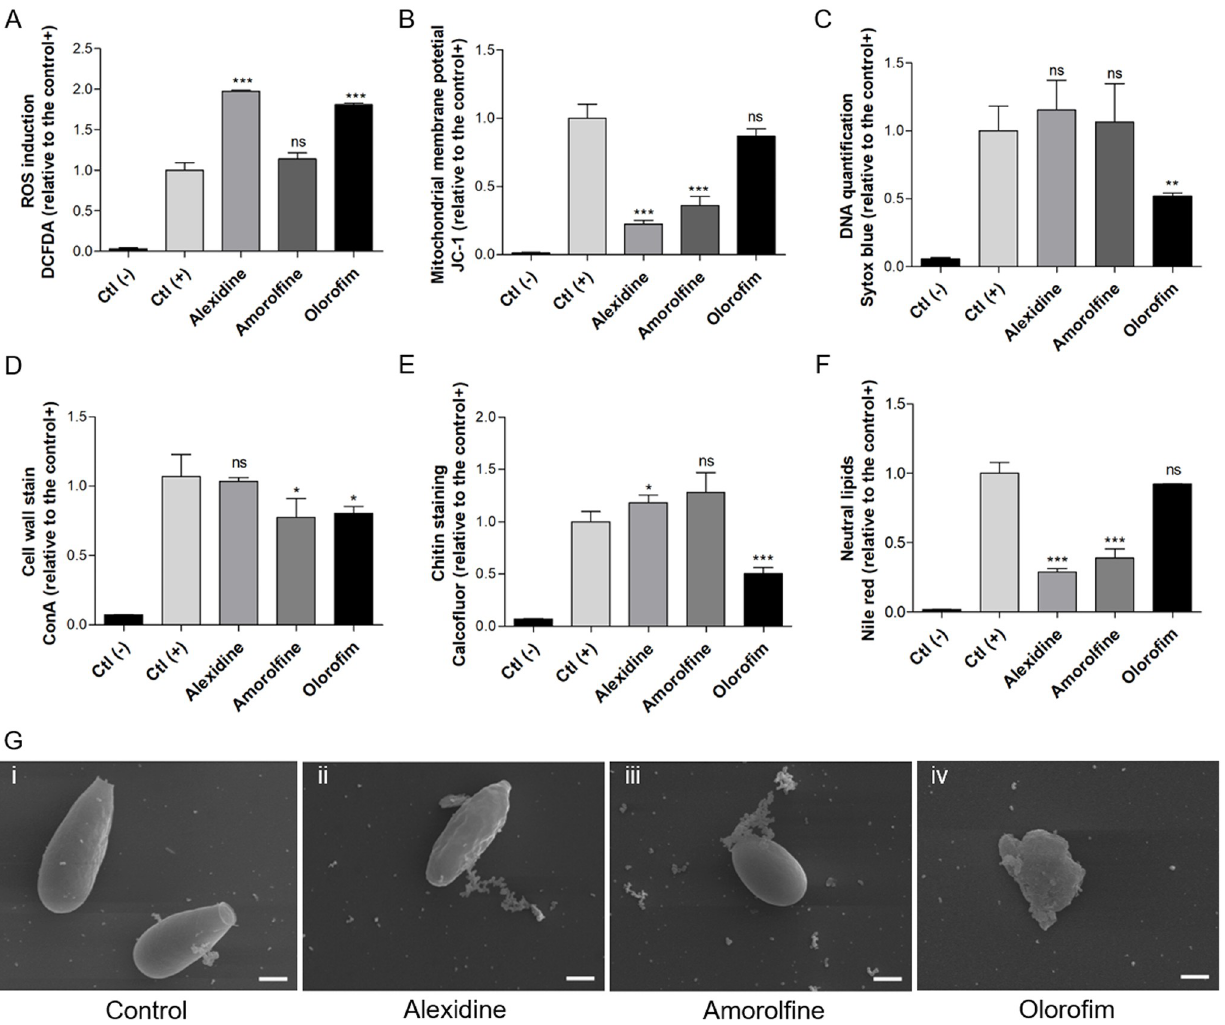
Fig 5. The effect of alexidine, amorolfine and olorofim on S . aurantiacum morphology and cell parameters. Cells were grown in the presence of ½ x MIC of alexidine, amorolfine or olorofim for 48 h at 37˚C. Oxidative stress was measured by DCFH-DA (A). Mitochondrial membrane polarization was measured by JC-1 (B). Intracellular DNA quantification was analyzed by Sytox blue staining (C). Concanavalin A was used to evaluate mannose residues (D). Chitin content was analyzed by calcofluor white (E). Neutral lipids were quantified using Nile Red stain (F). Scanning electron microscopy was performed following the same treatment conditions (G). Ctl (-), a negative control that represents cells in the absence of fluorescent stain. Ctl (+) a positive control that represents cells stained with fluorescent stain, but without drug treatment. Results of treated cells are represented as a relative expression compared to Ctl (+), in other words how many times the fluorescence intensity is observed compared to Ctl (+). � p < 0.05; �� p < 0.01; ��� p < 0.001; ns = not significant. Experiments were performed in quadruplicate, in three independent experimental